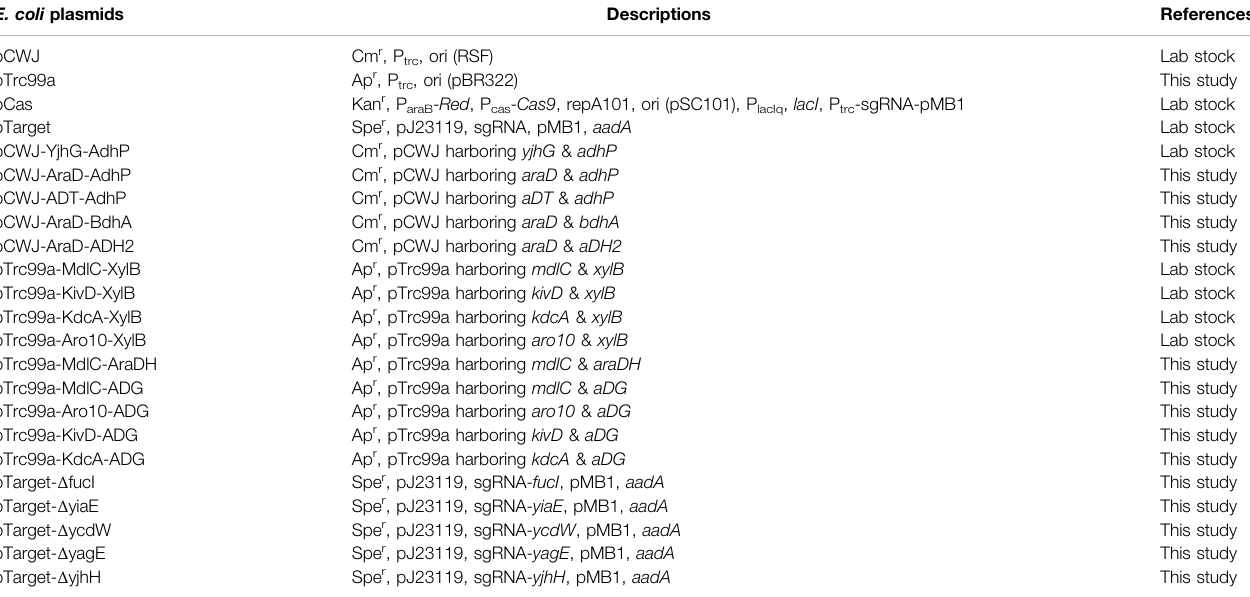
TABLE 2 | Plasmids used in this